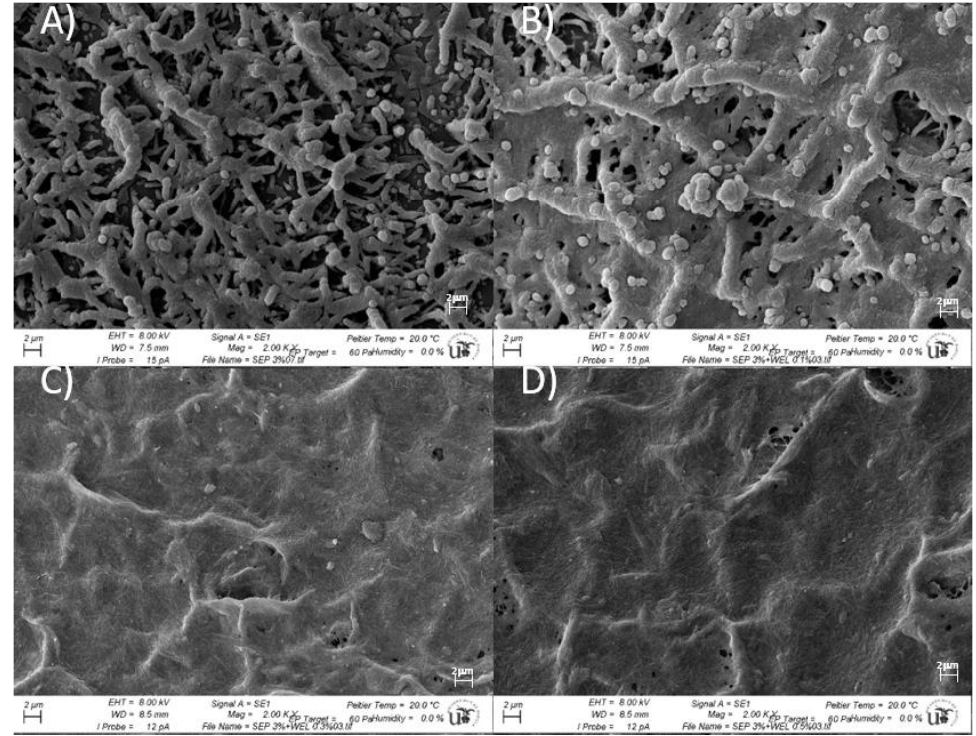
Figure 7. Cryo-SEM micrographs for sepiolite gels 3%wt. with different welan gum concentrations ( A ) 0%wt.,( B ) 0.1%wt., ( C ) 0.3%wt., and ( D ) 0.5%wt.